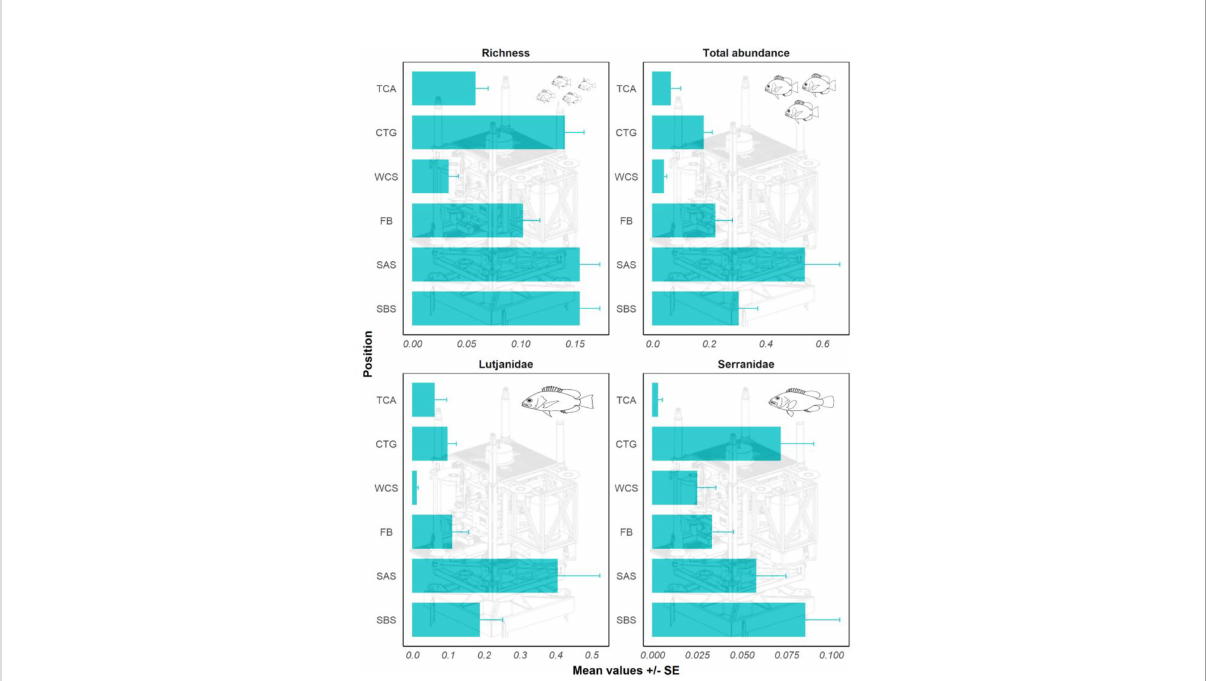
FIGURE 3 Fishery species richness, total abundance of fi shery target species (sum all MaxNs), and the abundance of Lutjanidae (snappers) and Serranidae (groupers) on different sections of NW wells. TCA, tree cap assembly; CTG, Christmas tree; WCS, water column around structure; FB, fl ow base; SAS, sea fl oor around structure; SBS, sea fl oor beneath structure, NW = north-west, SE =